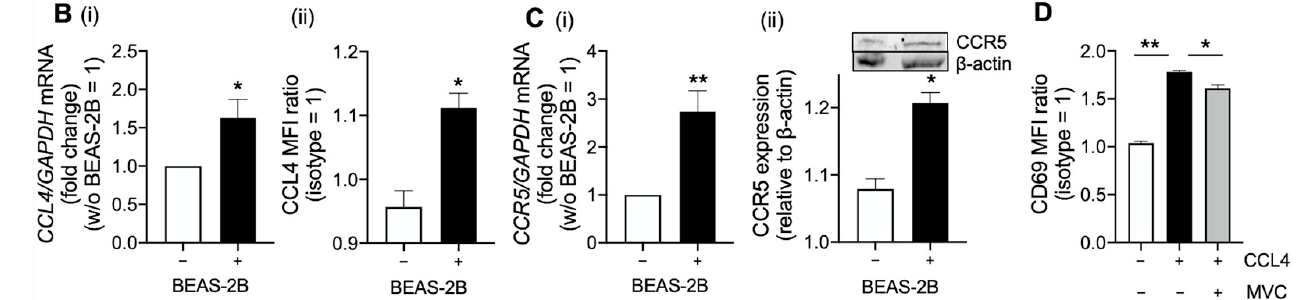
Figure 3. CCL4-mediated eosinophil activation. ( A ) Purified peripheral blood eosinophils coincu- bated with BEAS-2B cells were treated overnight with human recombinant CCL4. CD69 expression in eosinophils was evaluated [(i) percentage of CD69+ Siglec-8+ double-positive cells and (ii) CD69 median fluorescence intensity (MFI) ratio to isotype control]. ( B ) CCL4 mRNA (i) and protein (ii) expression in eosinophils coincubated with BEAS-2B cells. ( C ) CCR5 mRNA (i) and protein (ii) ex- pression in eosinophils coincubated with BEAS-2B cells. ( D ) Eosinophils pretreated with maraviroc (MVC)—a CCR5 antagonist—were stimulated with CCL4. The values represent the mean ± SEM of four experiments. * p < 0.05, ** p < 0.01 (between the two groups).